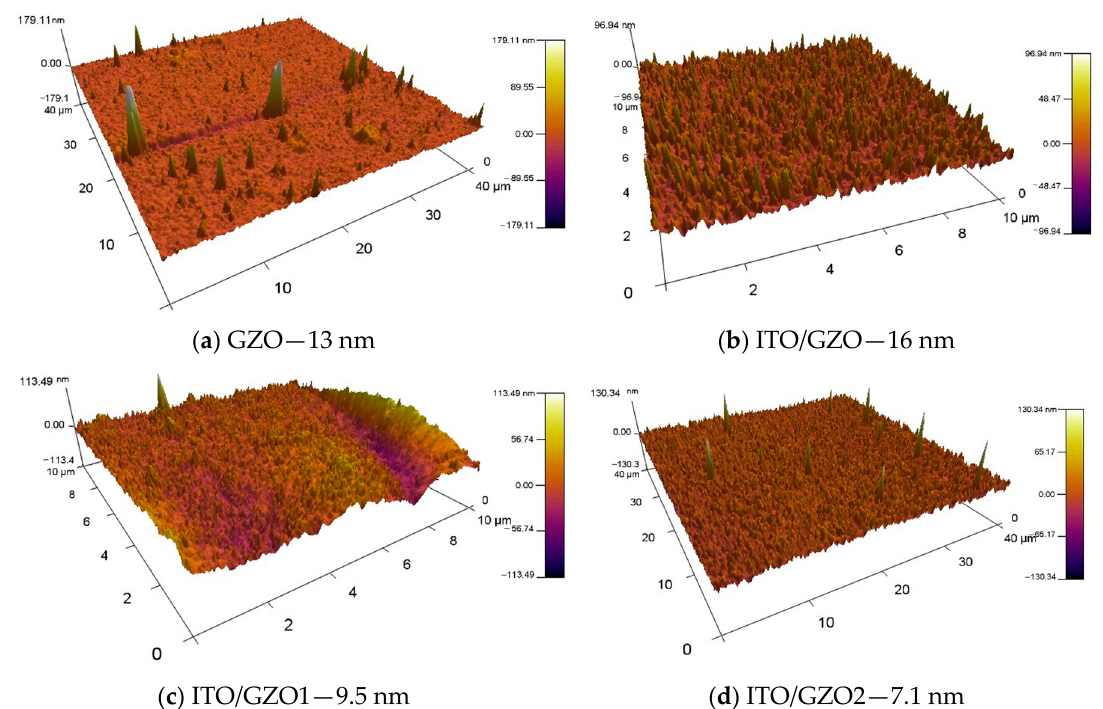
Figure 3. AFM images of ( a ) single GZO film; ( b ) bi-layer ITO/GZO without additional oxidation; ( c ) with 10% and ( d ) with 20% of additional